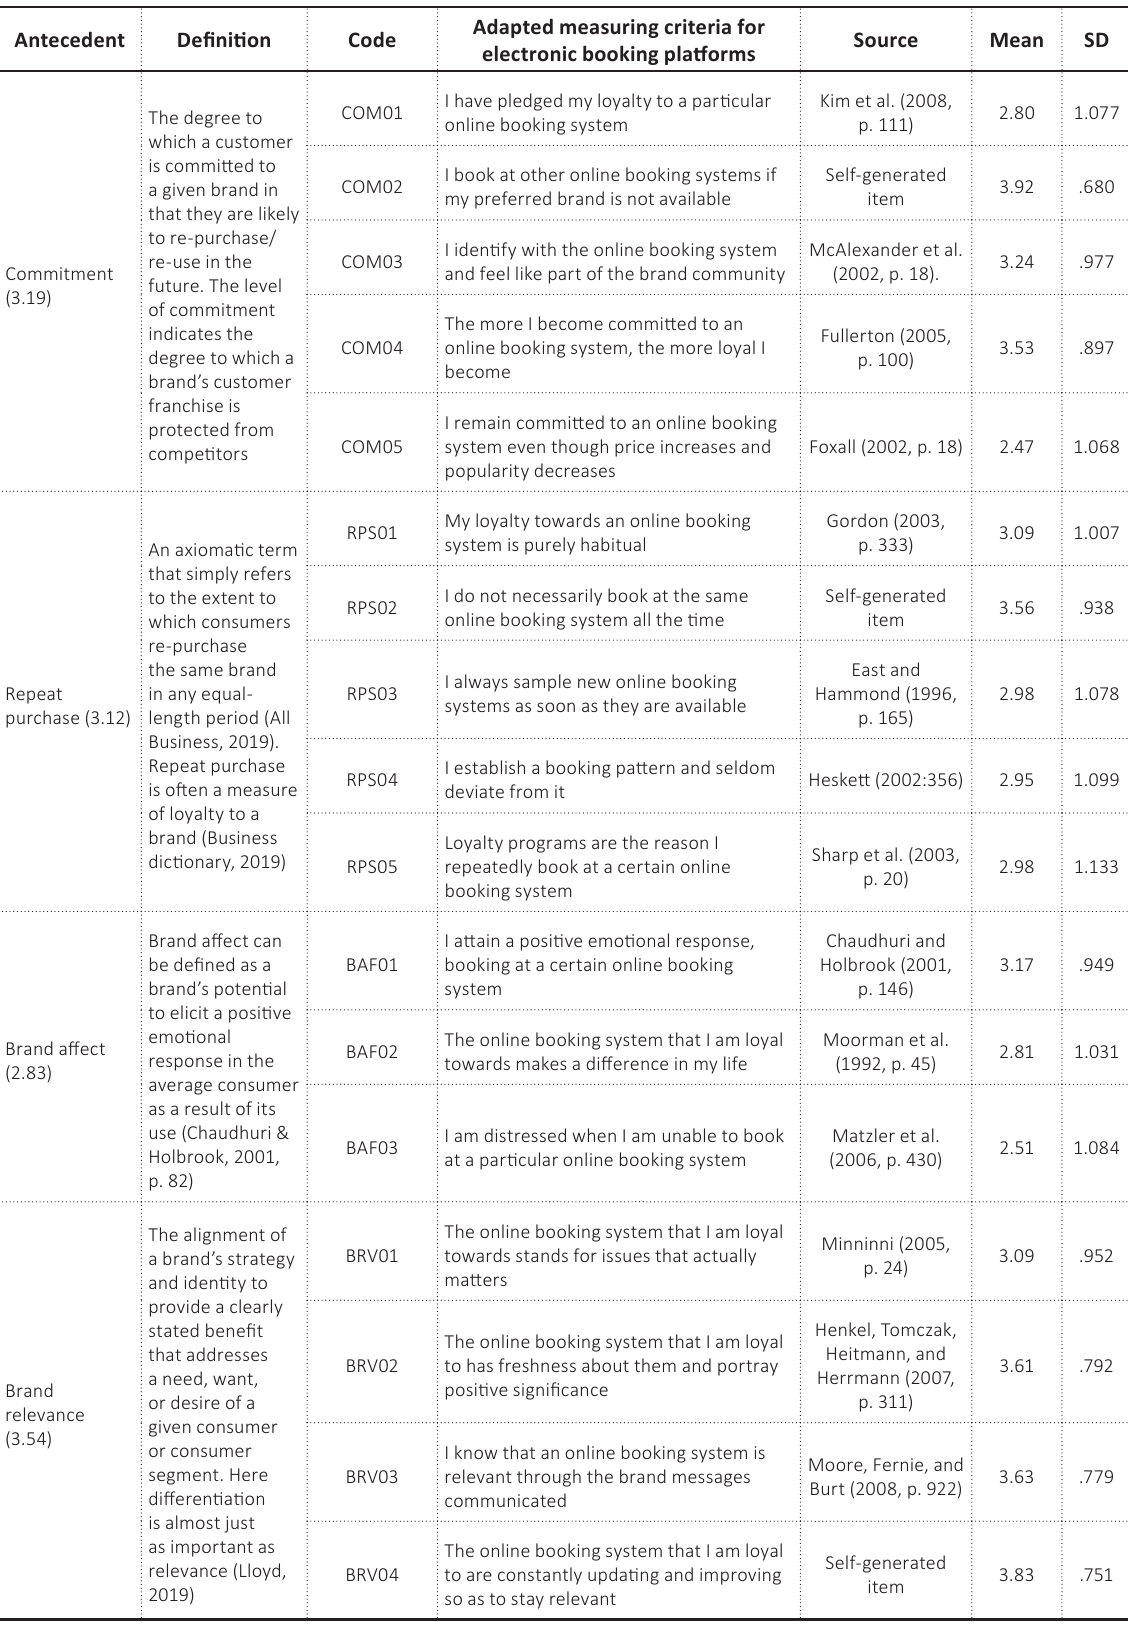
Table 1 (cont.). Descriptive statistics and the origins of the questionnaire